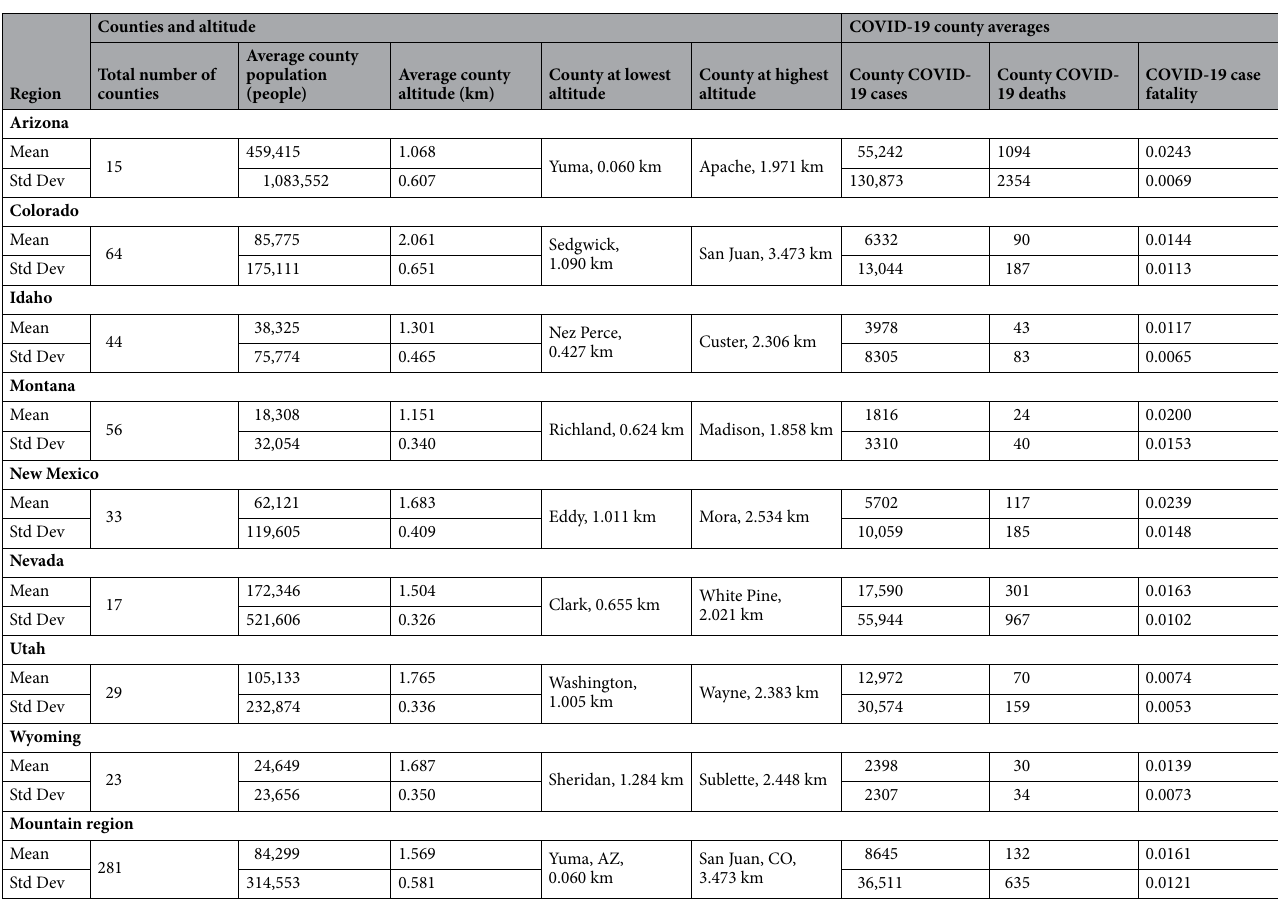
Table 1. Mean and standard deviations for county altitude and COVID-19 cases, deaths and case fatality by state and by mountain region. Fatality rate is expressed as the fatal COVID-19 cases/Total number of cases for each